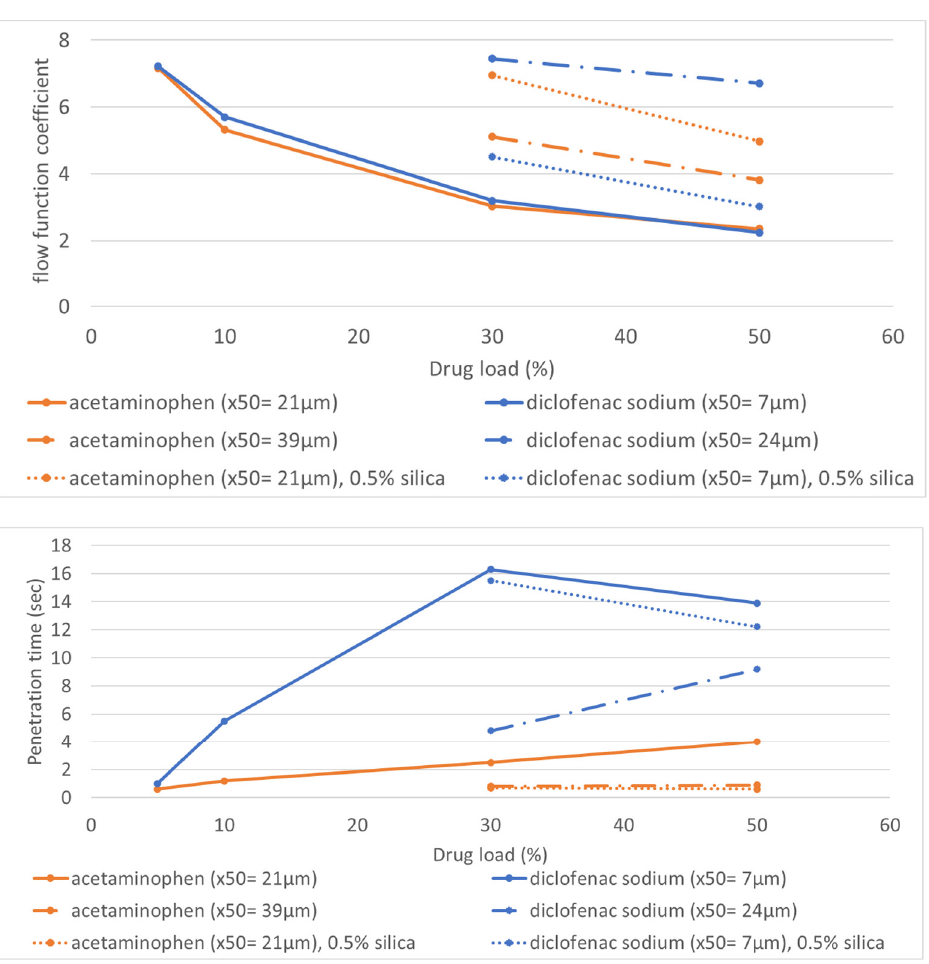
Figure 2. Flow expressed as FFC (upper panel) and penetration time measured via DSA (lower panel) at different drug load levels for both the hydrophilic and hydrophobic model compounds formulated with 20% w / w partially pregelatinized starch and lactose.